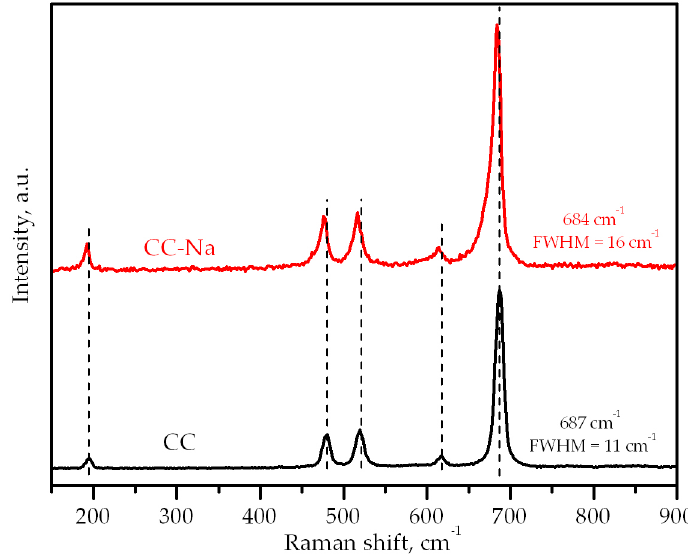
Figure 5. Raman spectra of the catalysts.